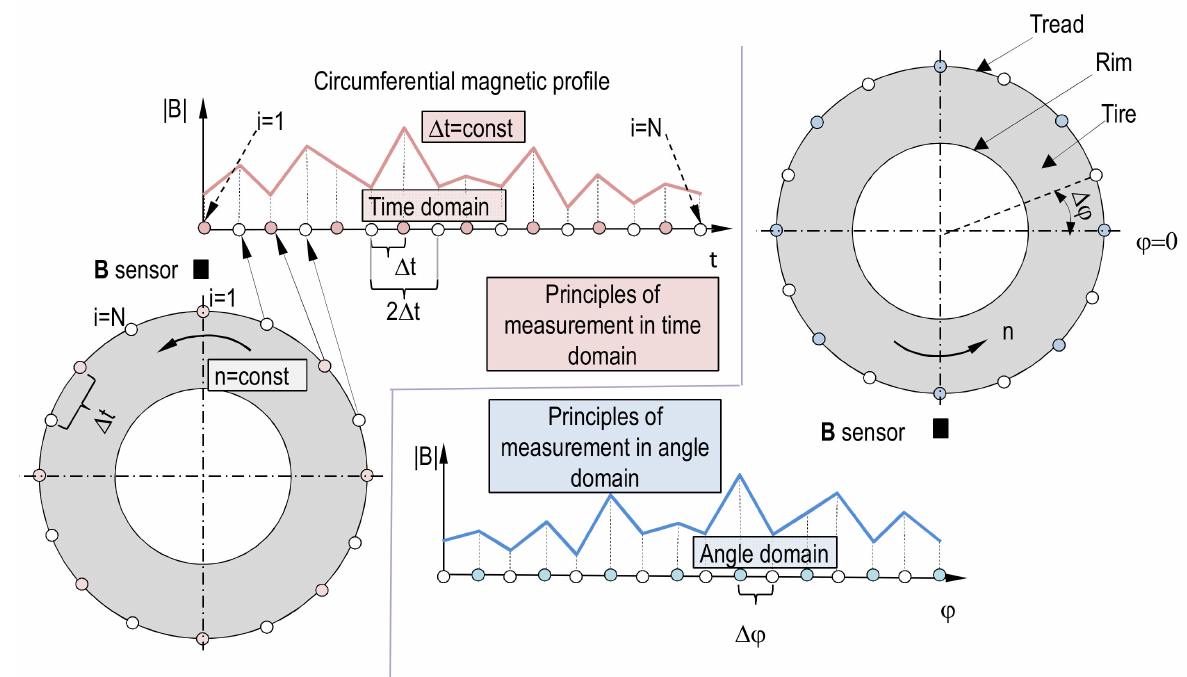
Figure 3. Schematic of two methods of measuring of circumferential magnetic profile (1D): In time domain and in angle domain. In this investigation, the ∆ ϕ method is